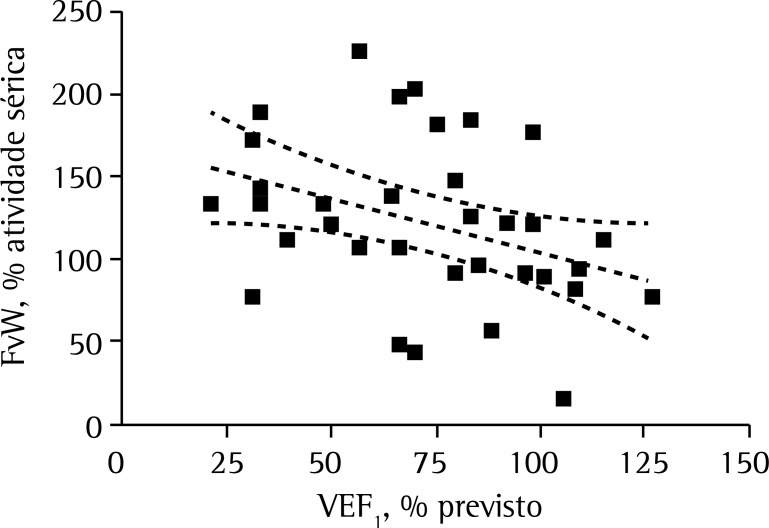
Relação entre os valores do percentual de atividade do fator de Von
Willebrand (FvW) e VEF1 em porcentagem do previsto (r2 = -0,13; p =
0,0099).